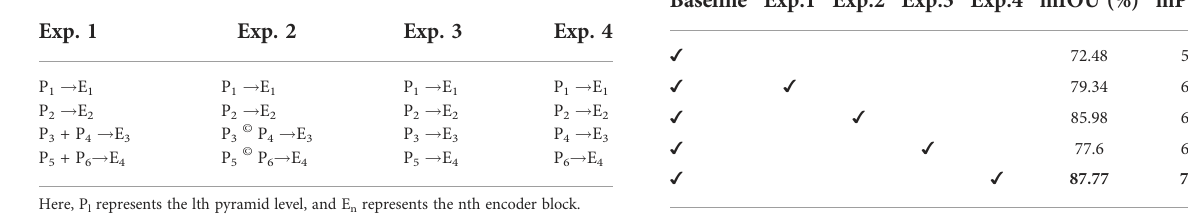
TABLE 9 Ablation experiments for different coupling